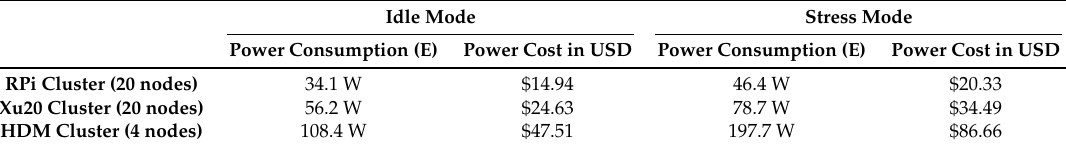
Table 3. Power consumption of clusters in idle and stress modes with Power cost per